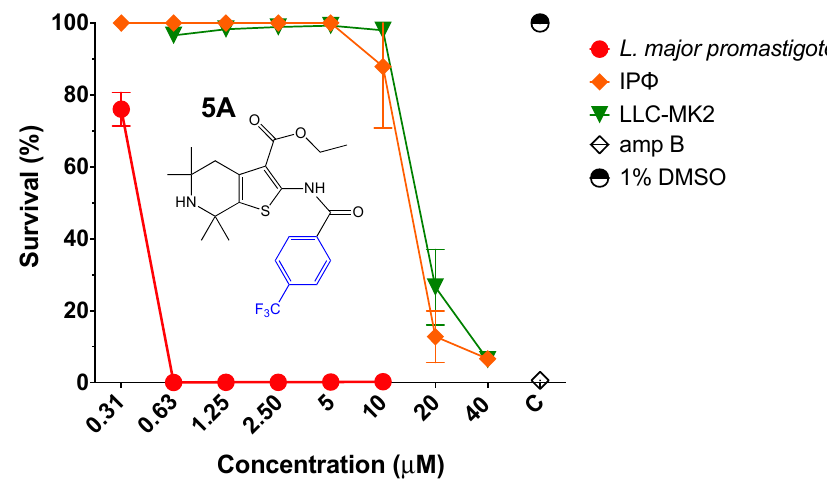
Figure 3. Antiparasitic effect of thiophene derivative 5A . Viability of L. major-luc promastigotes incubated with 5A at 0.31 to 10 µM for 72 h. Evaluation of intraperitoneal mouse macrophages (IP Φ ) cytotoxicity for 48 h, or monkey kidney cells (LLC-MK2) treated with 5A at concentrations of 0.31 to 40 µM for 72 h. Controls treated with 1% DMSO, or amphotericin B (amp B) at 5 µM. Table 1. Antiparasitic activity in L. major-luc promastigotes, and cytotoxicity to intraperitoneal mouse macrophages (IP Φ ) or monkey kidney cells (LLC-MK2) of 5A and analogs. EC 50 Median effective concentration. ± values are the estimated EC 50 interval. CC 50 Median cytotoxic concentration. ± values are the estimated CC 50 interval S.I. Selective Index (CC 50 mammalian cells)/(EC 50 in L. major-luc promastigotes).